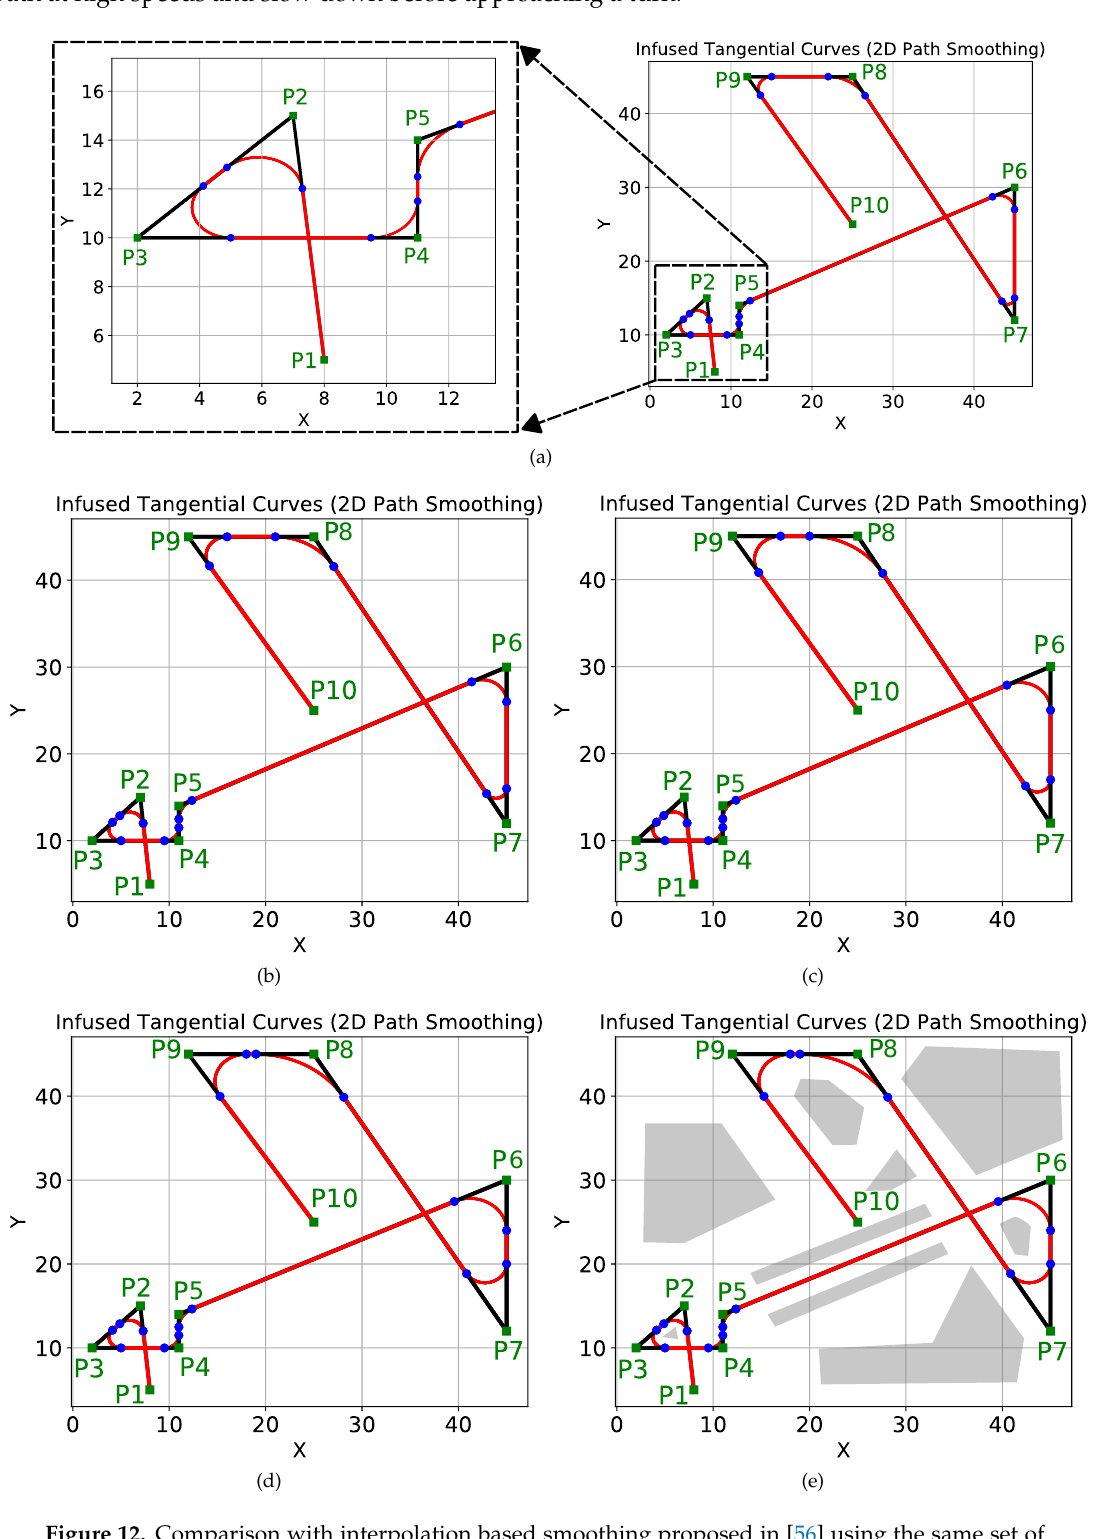
Figure 12. Comparison with interpolation based smoothing proposed in [56] using the same set of points. The various thresholds δ thresh in ( a – e ) are given in Table